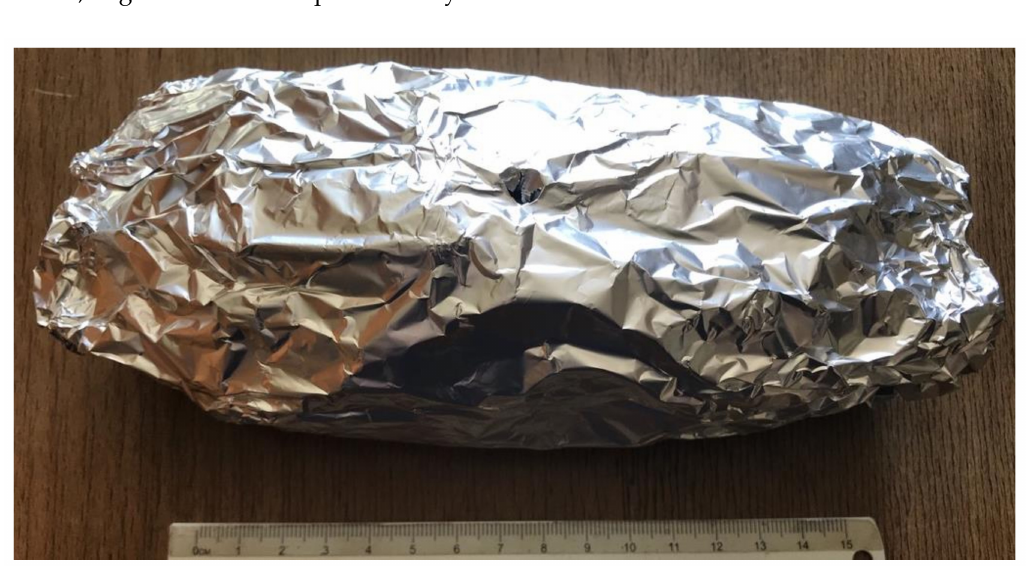
Figure 1. Assemblage of the samples in aluminum foil for torrefaction and pyrolysis tests.